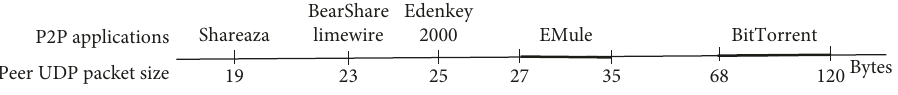
Figure 5: UDP communication packet in famous P2P application. Table 6: Example of equal incoming small packet